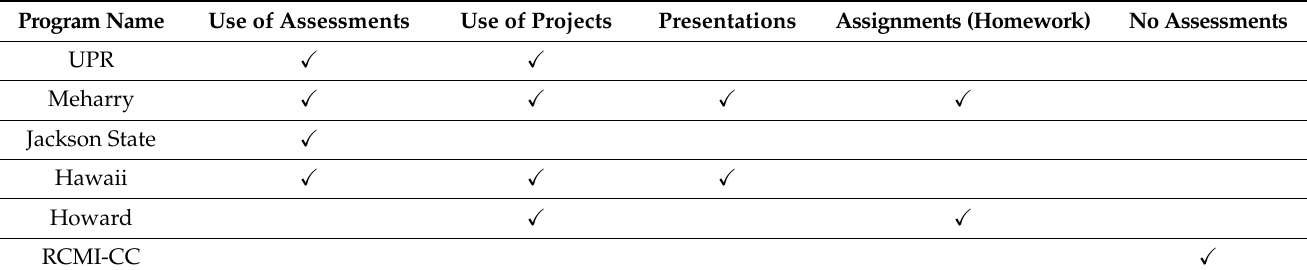
Table 7. Summary of program